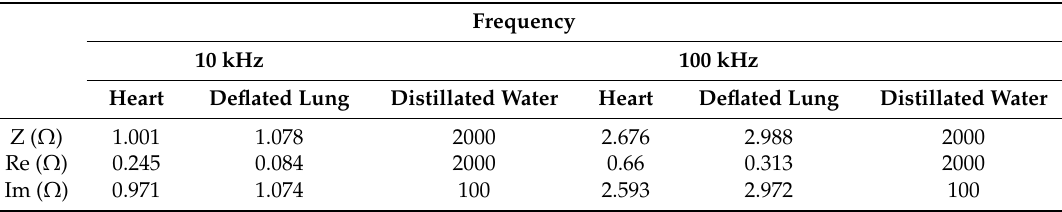
Table 2. Data of the electrical properties many tissue from